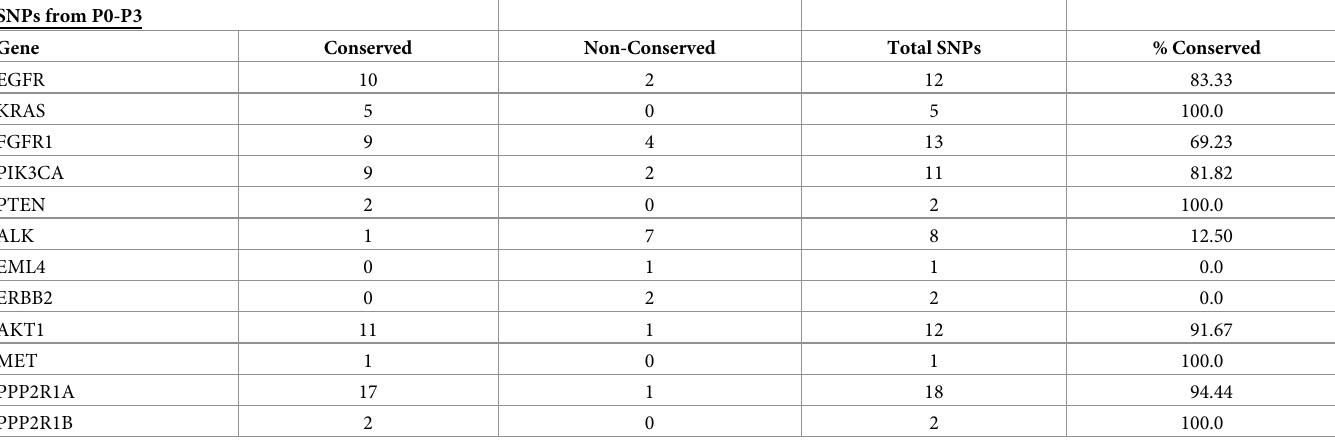
Table 2. Next generation sequencing results for PDX